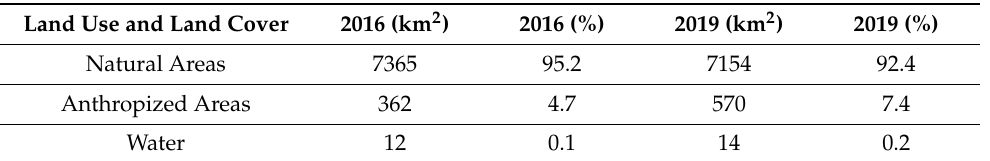
Figure 2. Land use and land cover maps resulting from the geographic object-based image analysis (GEOBIA) approach applied to the Apyterewa Indigenous Land in 2016 ( left ) and 2019 ( right ). In 2016, the anthropized areas (pasture, mining, agriculture and other human activities) represented 362 km 2 , totalling 4.7% of the Apyterewa Indigenous Land. The natural areas (forest and outcrop rocks) and water corresponded to 7365 km 2 (95.2%) and 12 km 2 (0.1%), respectively. In 2019, the anthropized areas increased to 570 km 2 , an increment of more than 200 km 2 , totalling 7.4% of the study area. Natural areas decreased in proportion, corresponding to 7154 km 2 (92.4%). Water bodies also increased in area, adding 14 km 2 , or 0.2%. These results are summarized in Table 1. Table 1. Land use and land cover classes resulting from the GEOBIA approach applied to the Apyterewa Indigenous Land in 2016 and 2019. Natural areas comprise forest and outcrop rocks and anthropized areas comprise pasture, mining, agriculture and other human activities.